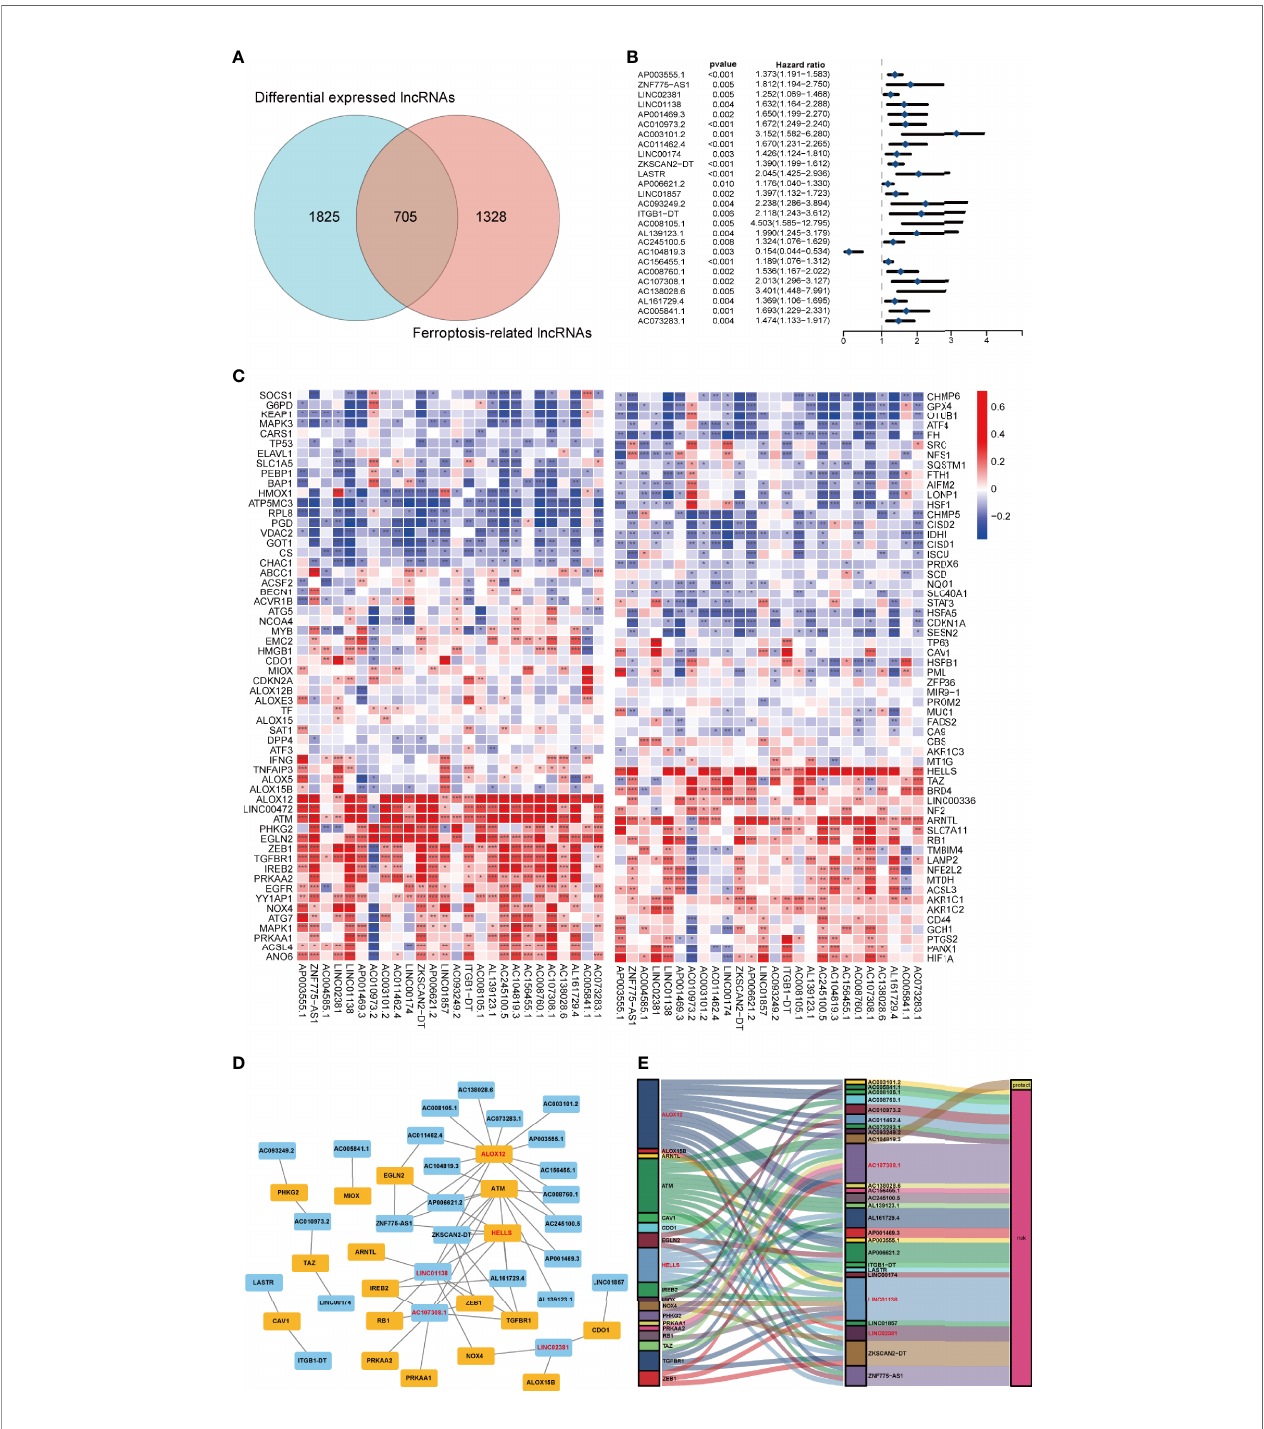
FIGURE 2 | Prognostic analysis of differentially expressed ferroptosis-related lncRNAs and the construction of a coexpression network. (A) Venn diagram to identify the common lncRNAs of differentially expressed lncRNAs and ferroptosis-related lncRNAs. (B) Forest plots showing the results of the Cox univariate regression analysis approximately 26 prognostic differentially expressed ferroptosis-related lncRNAs. (C) The correlation between 26 prognostic ferroptosis-related lncRNAs and 176 ferroptosis-related genes in the TCGA-COAD cohort. The colour of each unit shows the degree of corelation. *p < 0.05, **p < 0.01, and ***p < 0.001. (D) Coexpression network of candidate lncRNAs and ferroptosis-related genes. (E) The Sankey diagram presents the detail connection between ferroptosis-related lncRNAs and ferroptosis-related